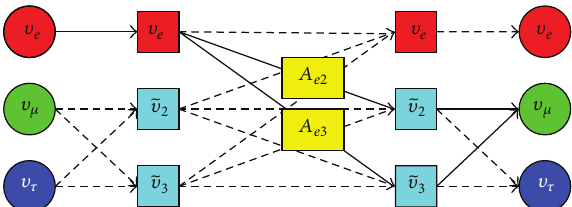
Figure 7: Scheme of transitions between the flavor states. Evolution is considered in the propagation basis ̃ ] . The lines which connect the flavor states and the propagation-basis states indicated projection of one basis onto another. The lines connecting the states of propagation basis ̃ ] show transitions between